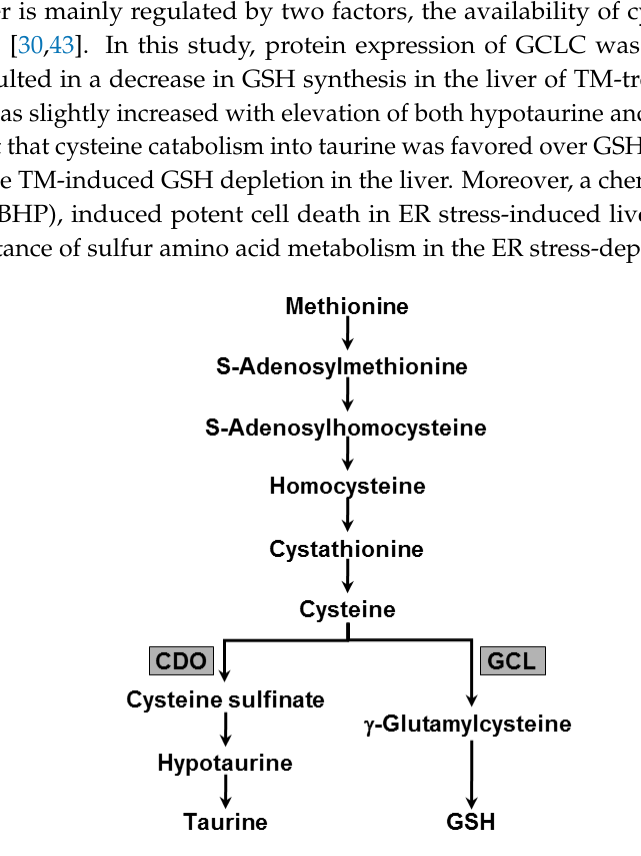
Figure 9. Transsulfuration pathway in the liver. CDO, cysteinedioxygenase; GCL, γ -glutamylcysteineligase; GSH, glutathione.